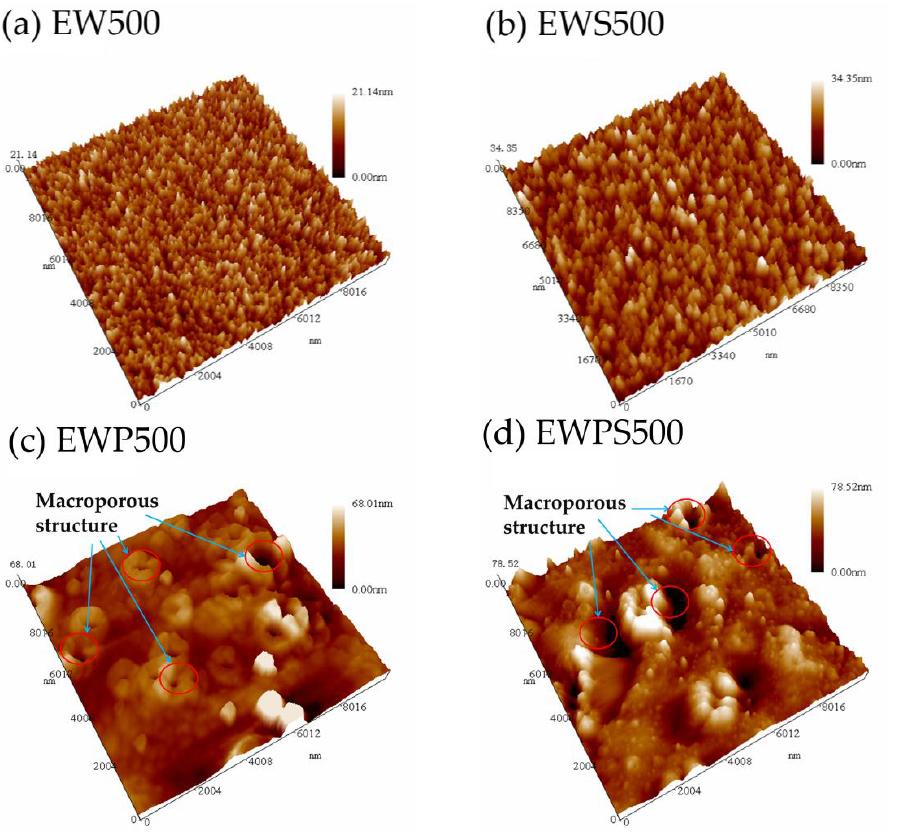
Figure 6. Atomic force microscope (AFM) 3D images (10,000 nm × 10,000 nm) of different WO 3 films: ( a ) EW500, ( b ) EWS500,( c ) EWP500, ( d ) EWPS500.